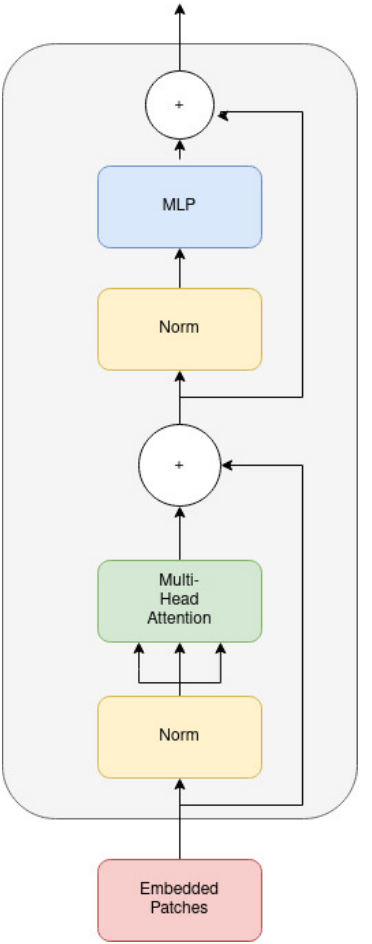
Figure 2. Transformer encoder: The illustration is inspired by